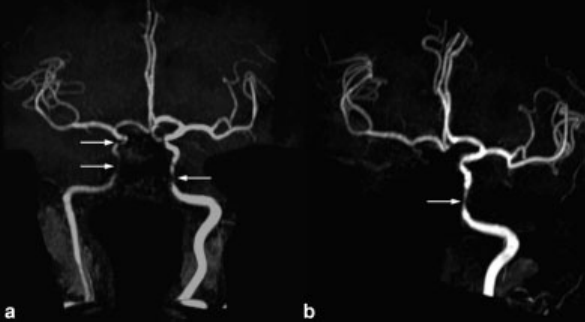
Fig.4 MR-angiography (time of fl ight imaging) ( a ) of the fi rst hospital admission showing bilateral ICA stenosis in the C3 – C6 segments, ( b ) performed 4 months later revealing right-sided ICA occlusion and left- sided stenosis consistent with ( a ). ICA, internal carotid artery.